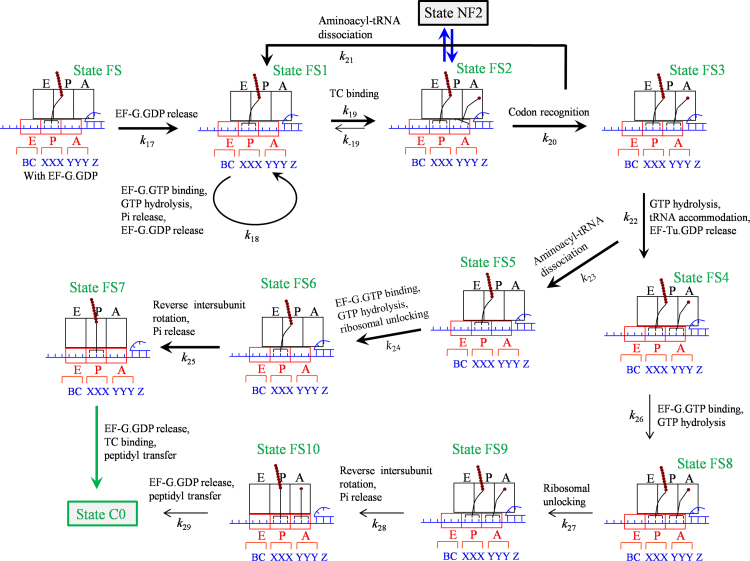
Schematic representation of the pathway after entering into the long-paused rotated state (see text for detailed description). State FS is the same as that shown in Fig. 3.